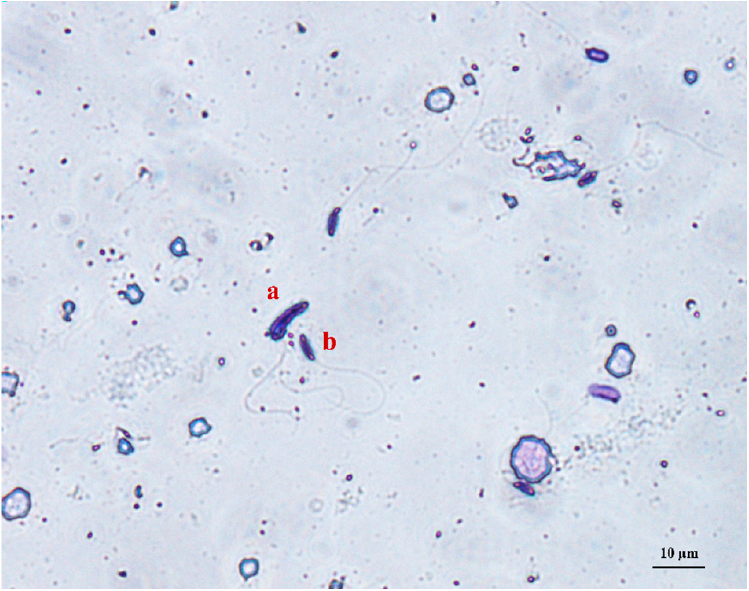
Figure 3. Spermatozoa with multiple defects (macrocephalic head and multiple tails) (a) and nor- mal spermatozoa (b) stained with Diff-Quik from peregrine falcon semen samples (×40).